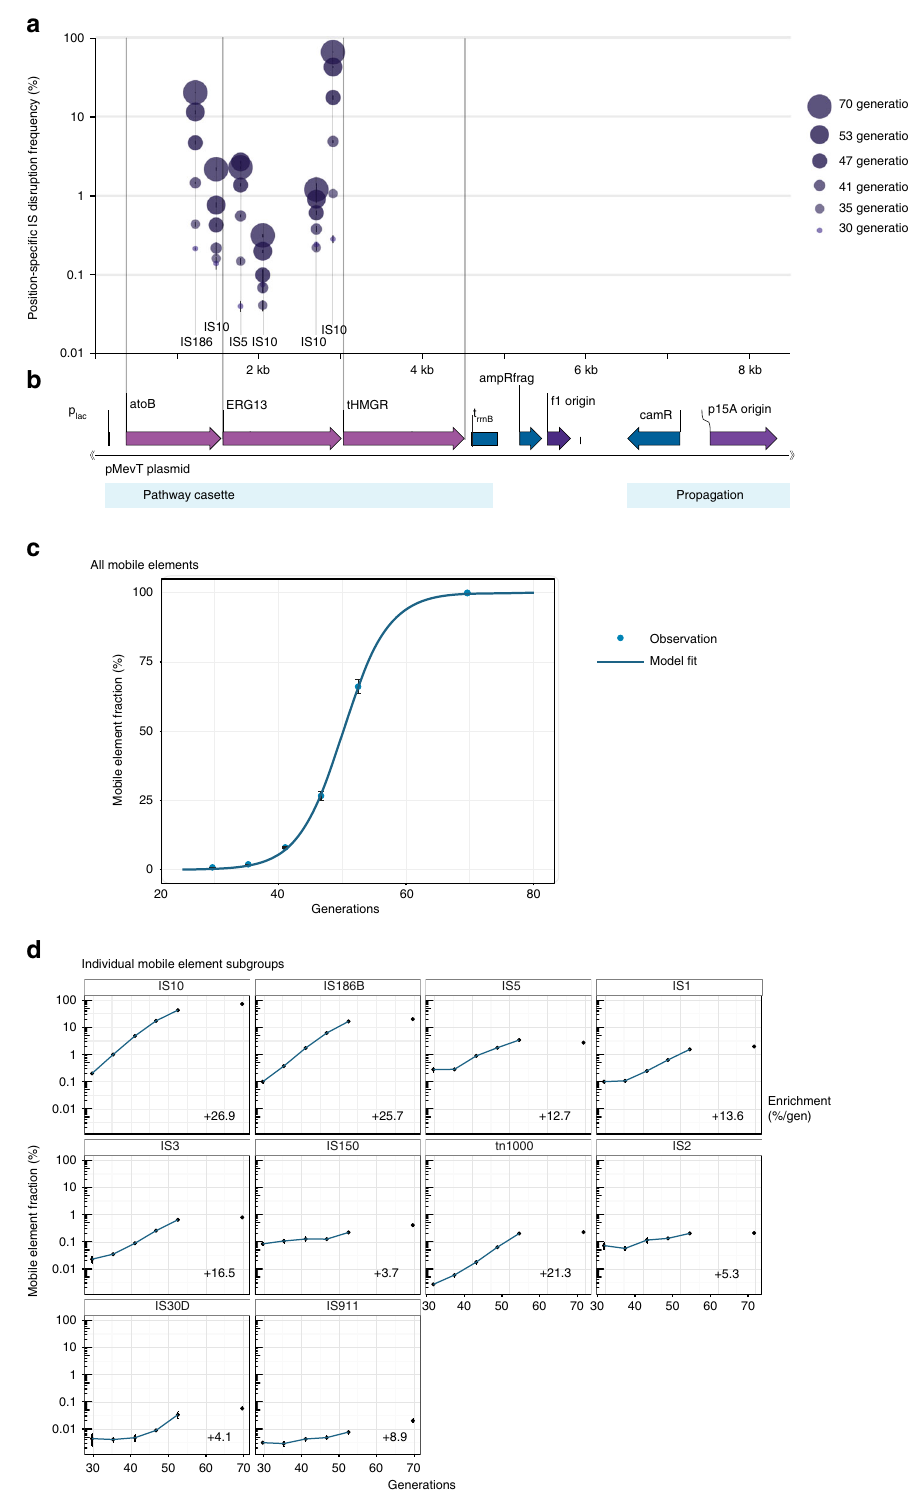
Fig. 4 Genetic pathway stability of a mevalonic acid-producing E . coli TOP10 clone in parallel lineages. a Time-lapse high-depth sequencing revealed rising frequencies (population fractions) of mobile element insertions. b The production plasmid pMevT, which encodes the genes atoB , ERG13 , and tHMGR in the mevalonic acid pathway. c Total enrichment of mobile elements in plasmid populations over the experimentally simulated fermentation period along with the model fi t. d Individual enrichment of host mobile elements in production plasmid populations over the simulated fermentation, and their percent-wise enrichment per generation in the exponential range (generations 30 – 53; regression statistics in Supplementary Table 7). For all the graphs, the error bars depict s.e.m. ( n = 3, except at generation 70: n =